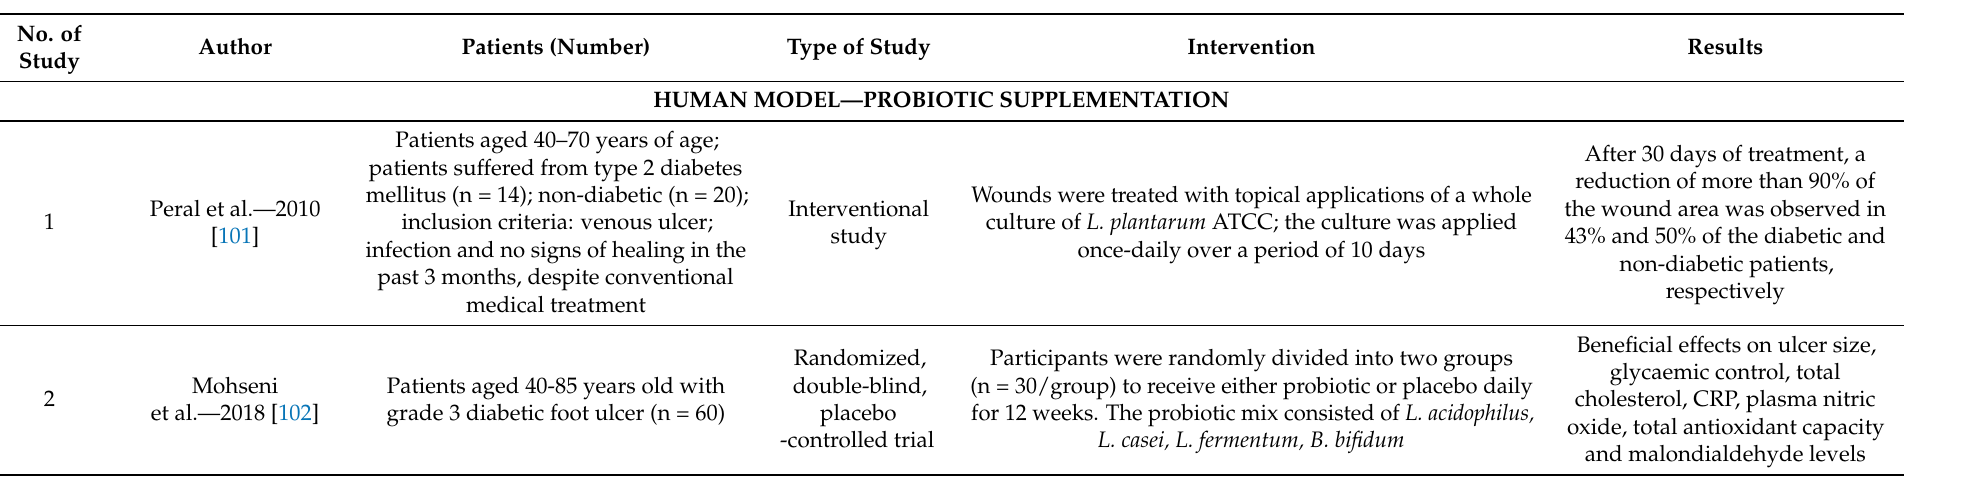
Table 7. Probiotic application in chronic